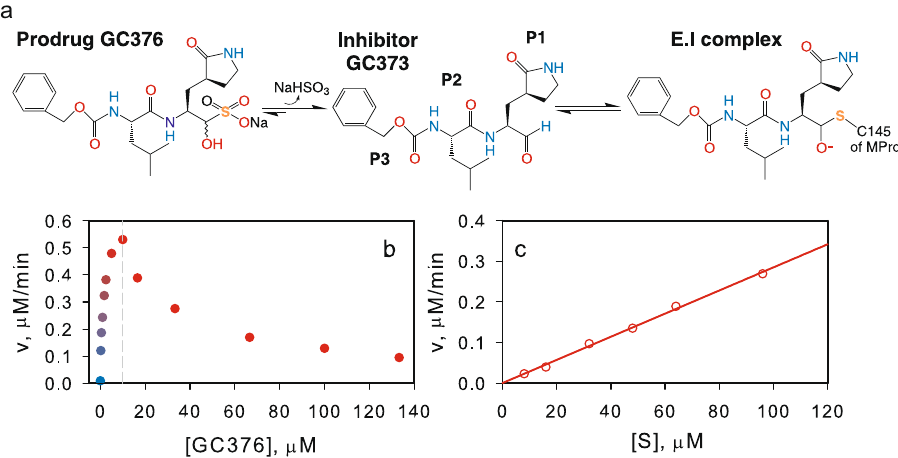
Fig. 5 Modulation of the catalytic activity of MPro M by feline coronavirus prodrug GC376. a Chemical structure of GC376 and steps in its binding to the active site of 3C and 3CL proteases 40,41 . b Catalytic activity of 10 µ M MPro M as a function of increasing GC376 concentration. c A plot of the rate vs